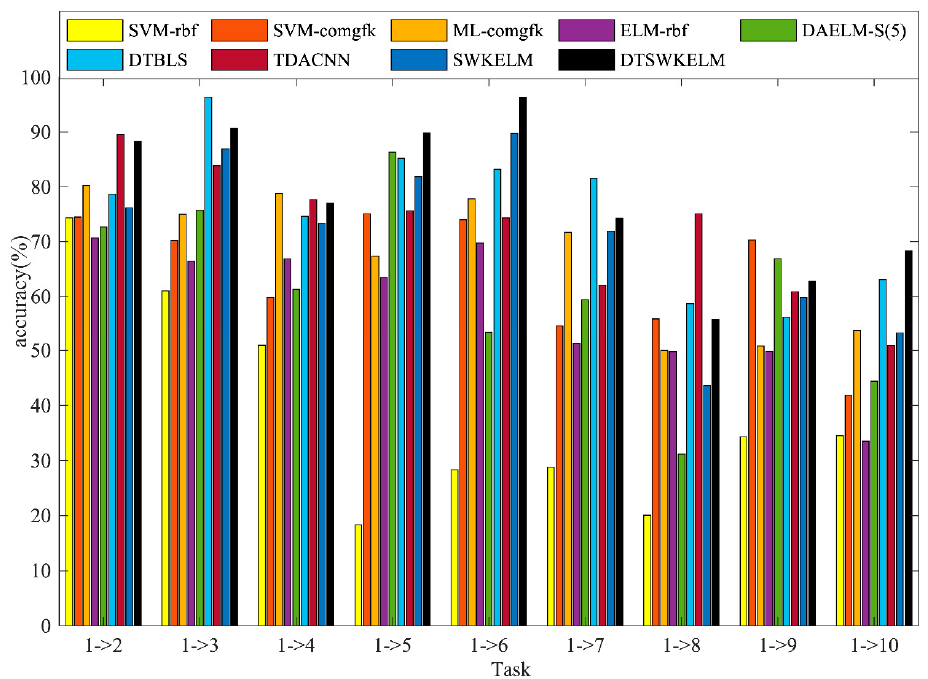
Figure 4. The histogram of the recognition effect of each algorithm in Experiment 1.